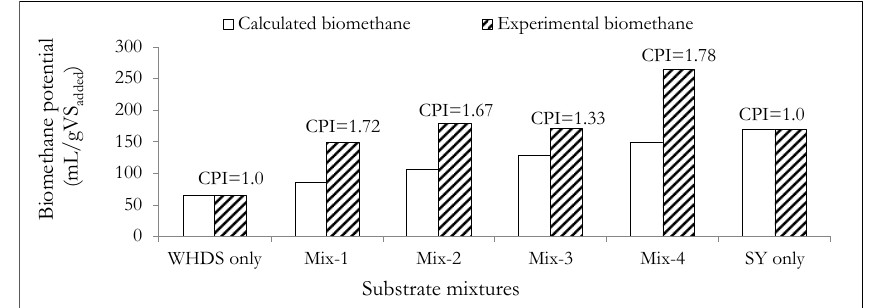
Figure 6. A comparative assessment of the calculated and the experimentally determined biomethane potentials. The mass ratios of the volatile solids of WHDS to the volatile solids of SY for the different substrate mixtures are listed in Table 3.